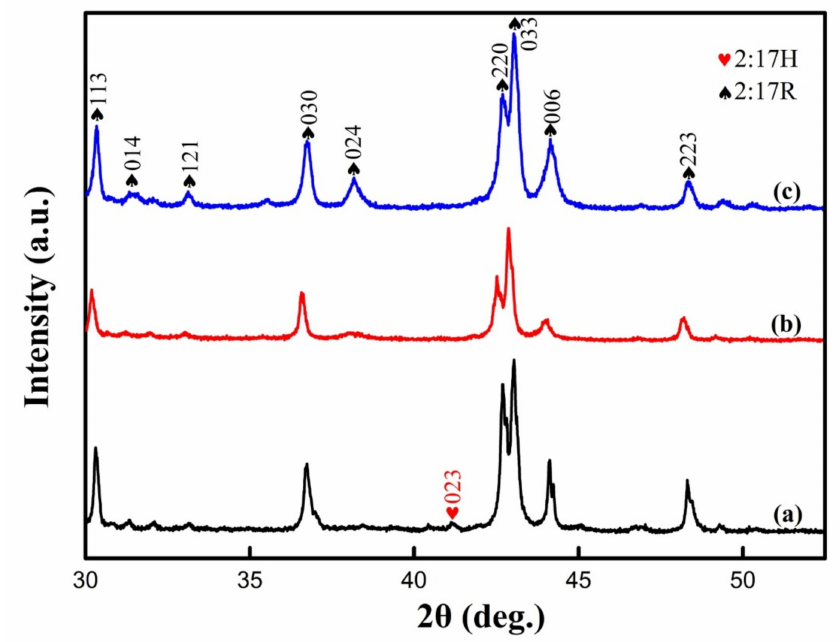
Figure 2. Powder XRD patterns of Sm 25 Co 46.9 Fe 19.5 Cu 5.6 Zr 3.0 magnets: solution-treated ( a ), aged for 0.5 h at 810 ◦ C ( b ), and the final magnet ( c